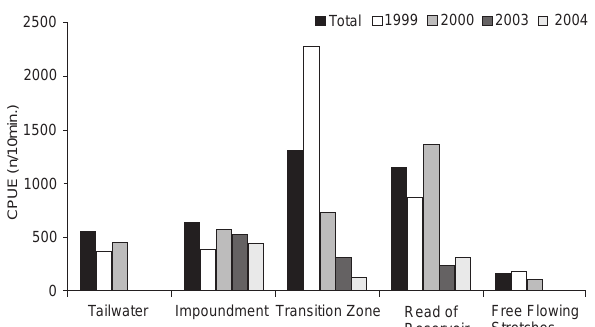
Figure 2. Fish frequency based on CPUE in each section of the investigation area.